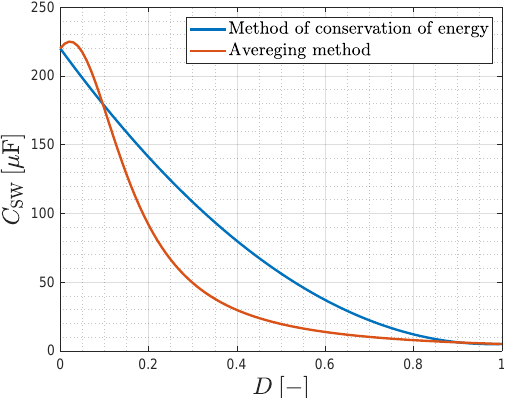
Figure 9. The variable capacitance of the switched capacitors as a function of the duty cycle for both